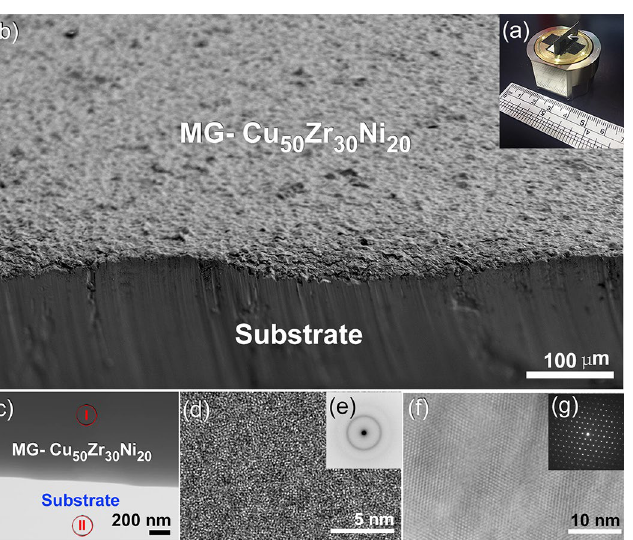
Figure 14. Effect of cold spray on the structure and thermal stability of MG Cu 50 Zr 30 Ni 20 powders. XRD pattern of MG Cu 50 Zr 30 Ni 20 powders obtained after 50 h of MA time are displayed in ( a ). The XRD pattern and corresponding DSC thermogram of the MA powders that were cold spray at 550 °C are displayed in ( b ) and ( c ), respectively. The XRD patterns of the cold sprayed MG powders heated up to 600 °C, and 700 °C, are displayed in ( d ) and ( e ), respectively.